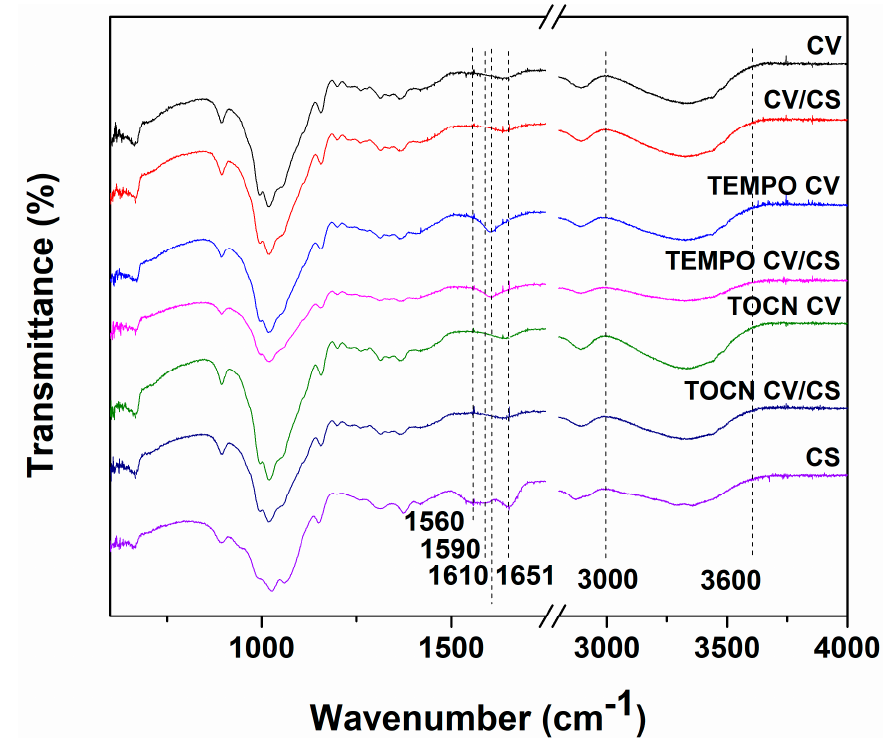
Figure 1. FTIR spectra of viscose fabrics before and after chitosan functionalization.